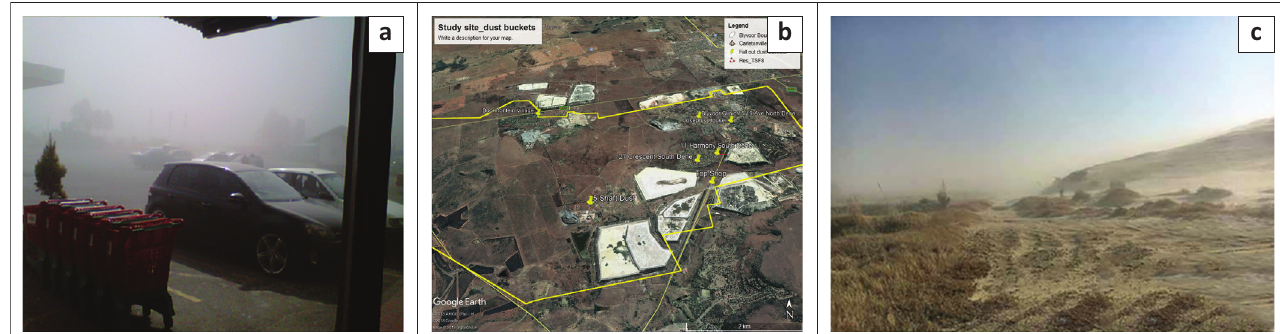
FIGURE 2: (a) Tailings storage facility 6, (b) located close to the community, with (c) dust fallout.